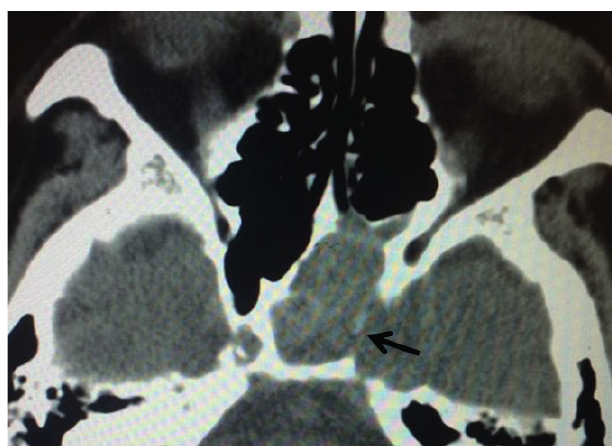
Figure 1. Axial view of computed tomography (case 1) showing exten- sive bone destruction of the lateral wall of left sphenoid sinus (an